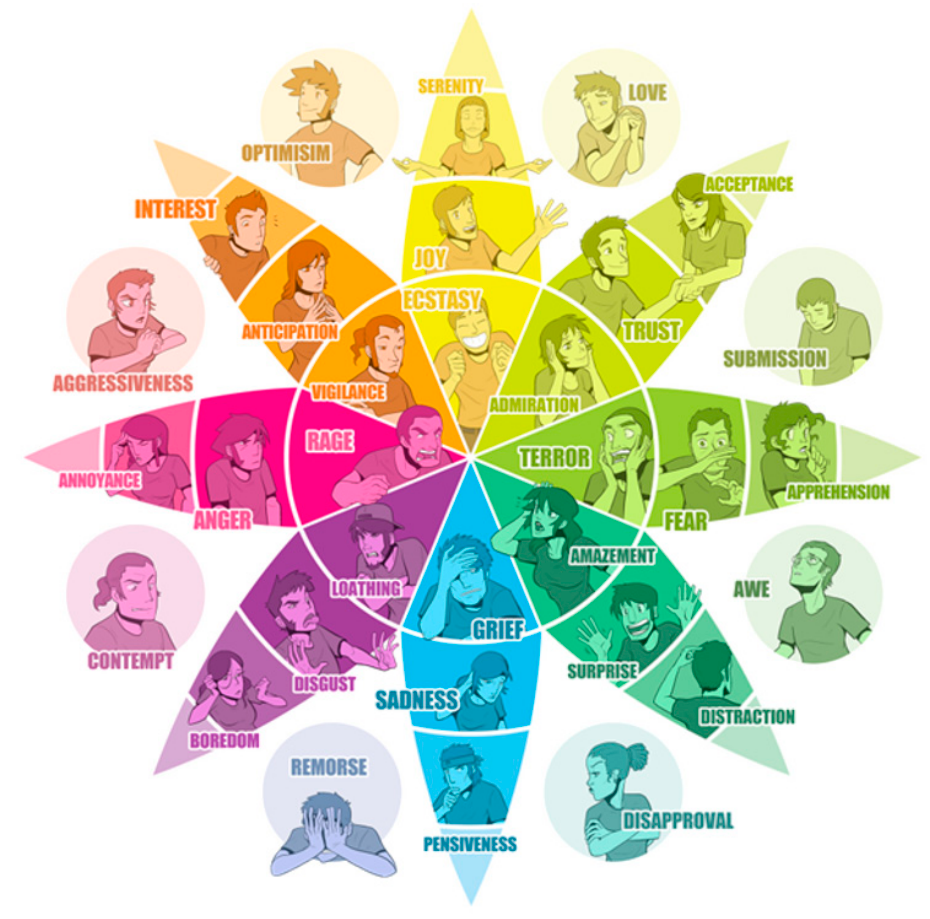
Figure 4. Robert Plutchik’s “wheel of emotions” [22].